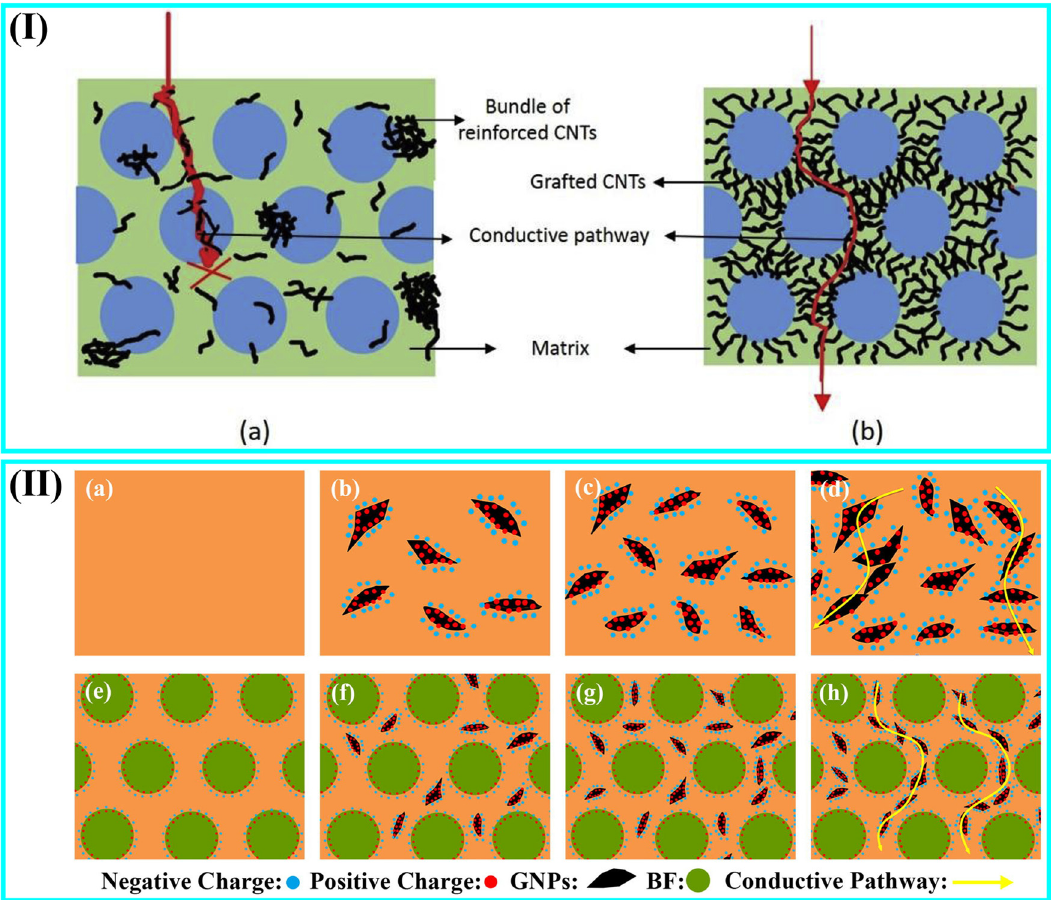
Figure 3: Comparison of conductive network formed by directly adding nano - conductive fi ller and loading nano - conductive fi ller on fi ber surface. ( Ⅰ ) Conductive network of CNTs: ( a ) directly adding and ( b ) surface loading on BF [ 45 ] . ( Ⅱ ) Conductive network of rGO: ( a – d ) rGO was added directly ( the addition amount of rGO are 0, 0.5, 1 and 2 wt%, respectively ) , ( e – h ) rGO was added based on surface - modi fi ed BF ( the addition amount of rGO are 0, 0.15, 0.24 and 0.41 wt%, respectively ) [ 46 ]